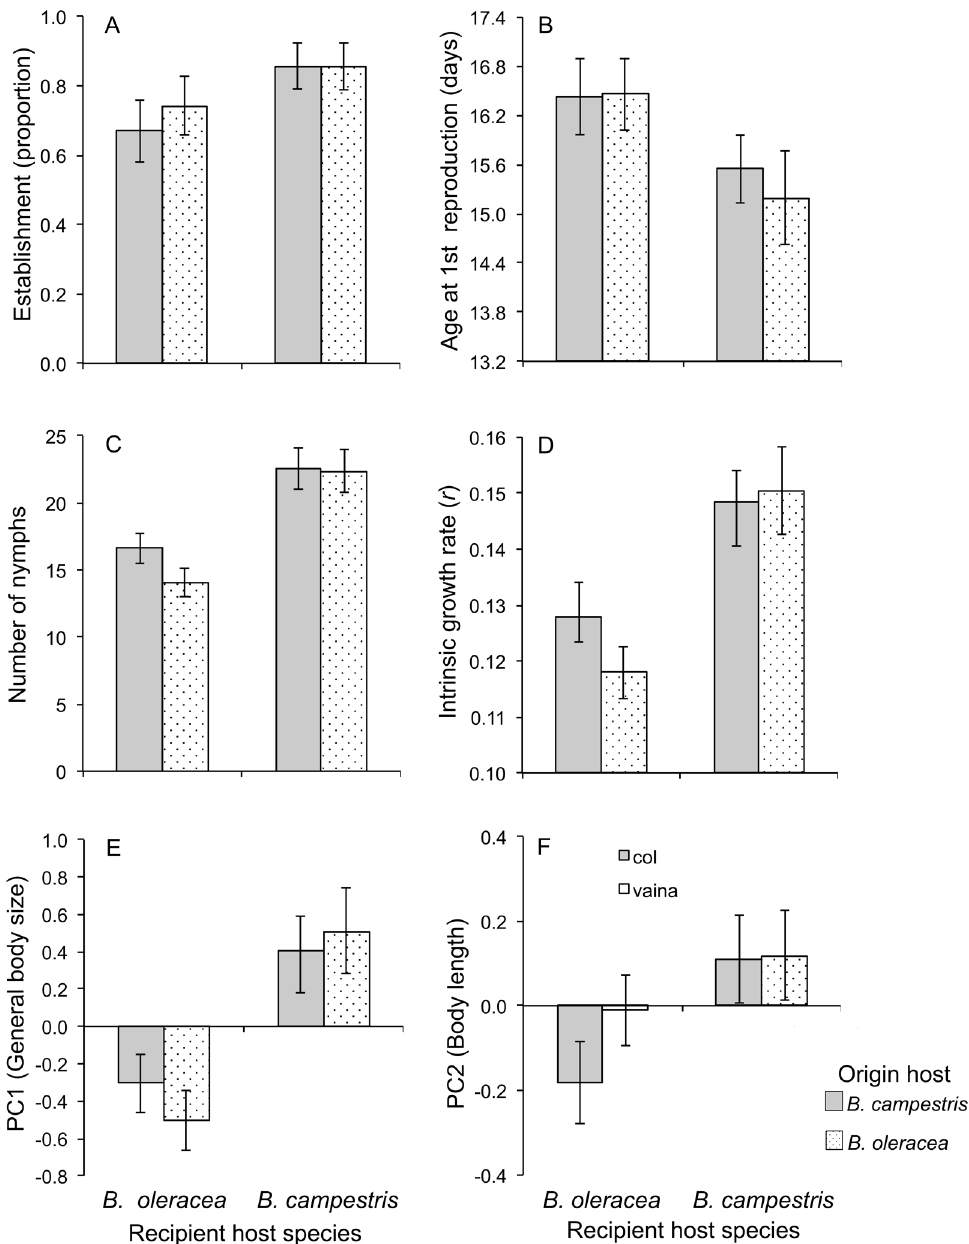
Figure 1. Average values ( ± SE) of morphological (PC1 and PC2) and life history traits of populations of Brevicorynebrassicae associated with Brassicaoleracea and Brassicacampestris .